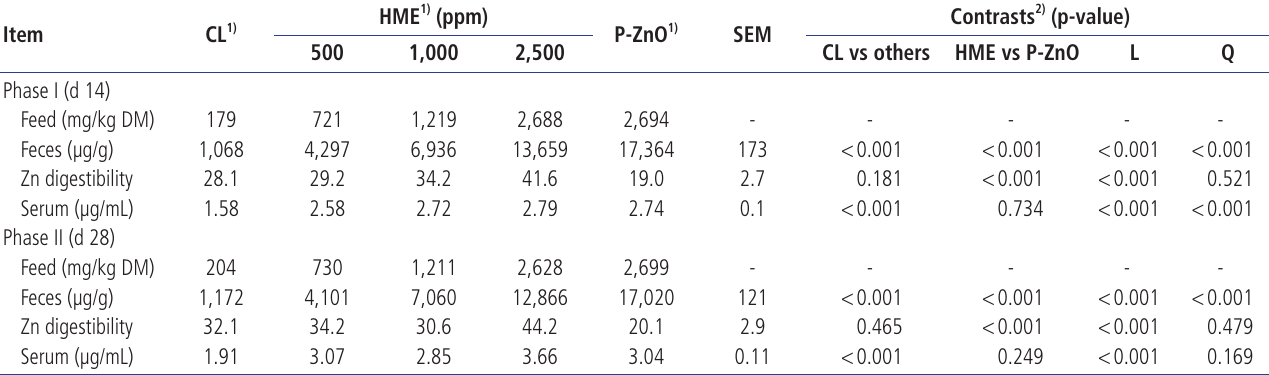
Table 5. Effects of different ZnO sources on Zn concentration of feces and serum in weanling pigs Item